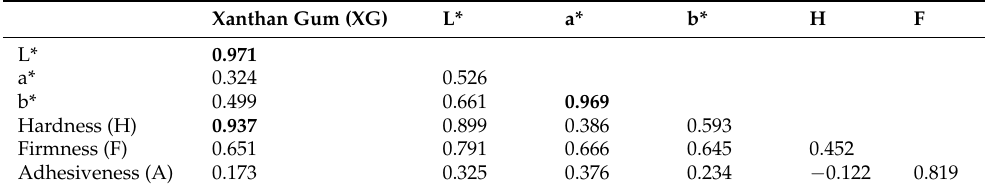
Table 6. Correlations between parameters measured for walnut butter samples with Jerusalem artichoke powder and xanthan gum (Pearson